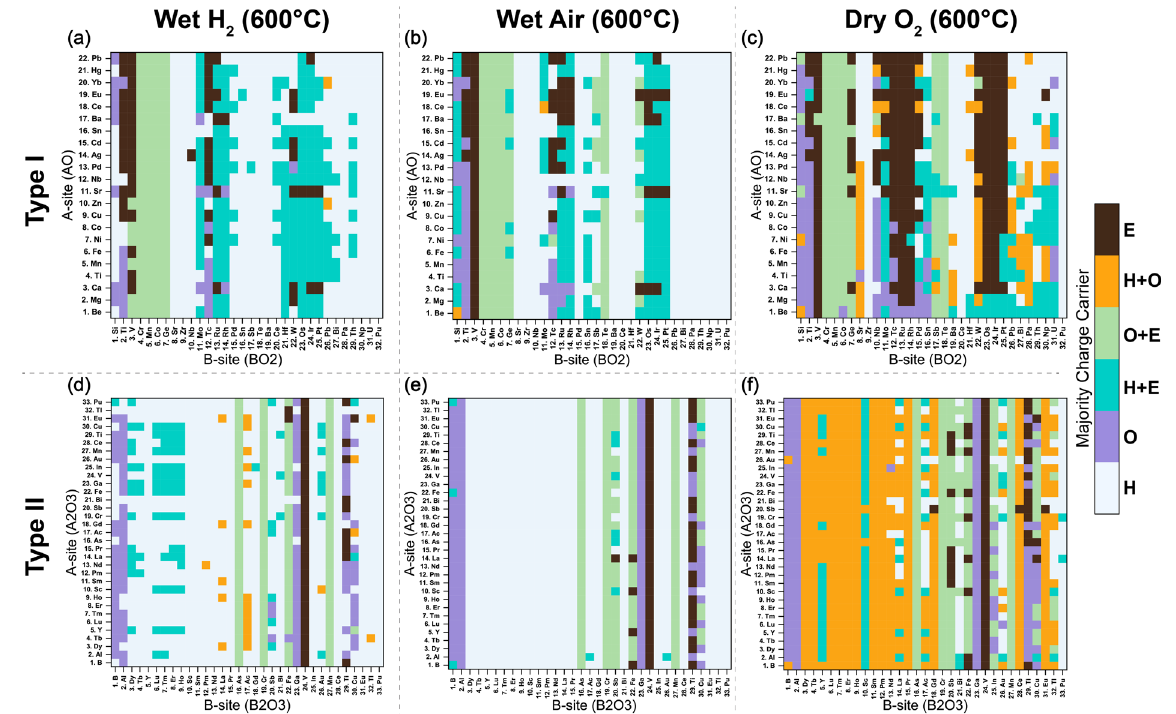
Fig. 4 The effect of atmosphere on total conductivity of screened (from ML model) perovskites. Type I (AO + BO 2 ), shown in plots a – c , and type II (A 2 O 3 + A 2 O 3 ), shown in plots d – f , perovskites. The conductivities are shown at atmospheres of wet (3% H 2 O) H 2 ( a , d ); wet air ( b , e ); and pure O 2 ( c , f ). The white region refers to proton conductors, purple to oxide ion conductors, dark green to mixed protonic/electronic, light green to mixed oxide/electronic, orange to mixed protonic/oxide, and brown to purely electronic conductors. There is a transition from protonic to electronic conductivity indicated by increase in electronic (brown) and mixed protonic and mixed oxide (green) colors due to inclusion of holes in presence of O 2